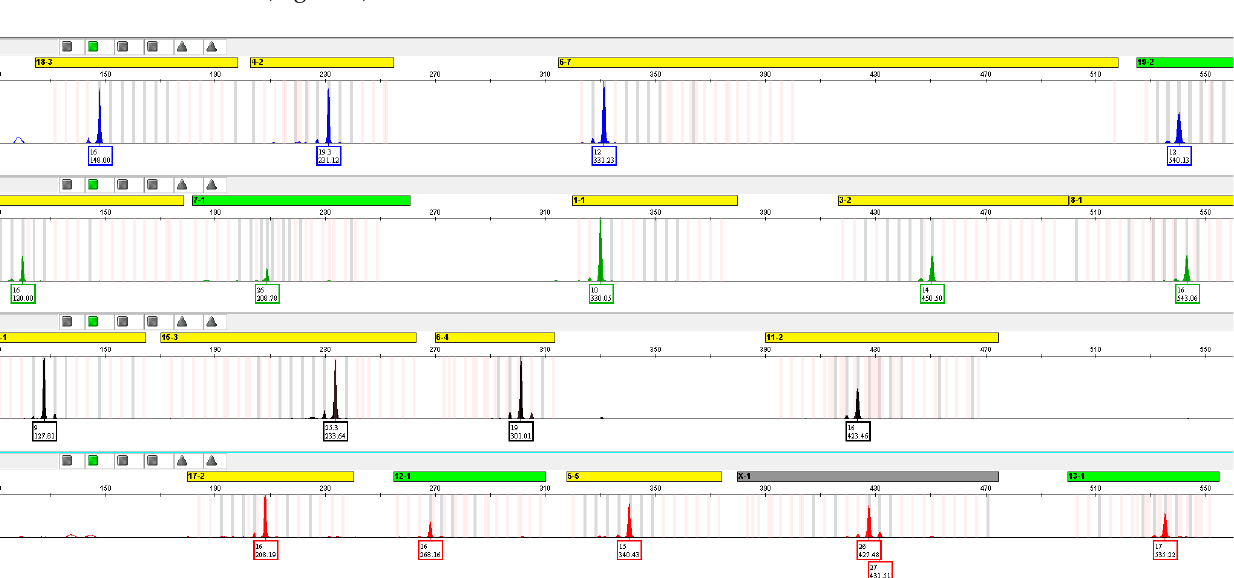
Table 1. Matching of the 18 short tandem repeats (STRs) obtained for GRX cells to known STR pro- files listed in Cellosaurus database *.